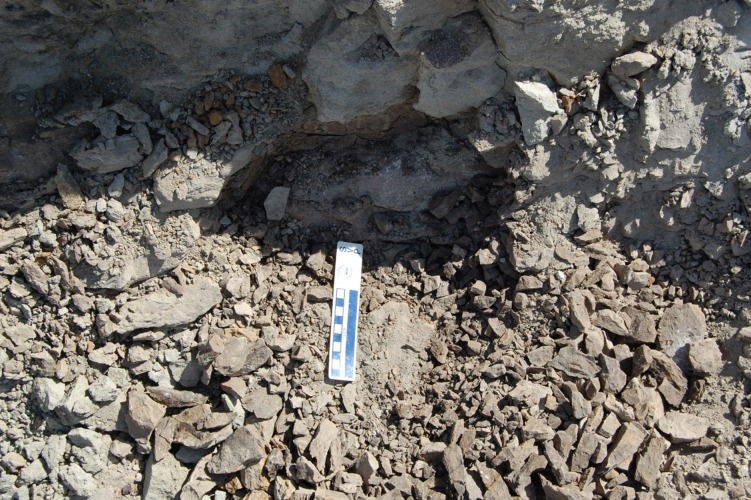
Mudstone from overburden-removed area of BB180 after sampling.